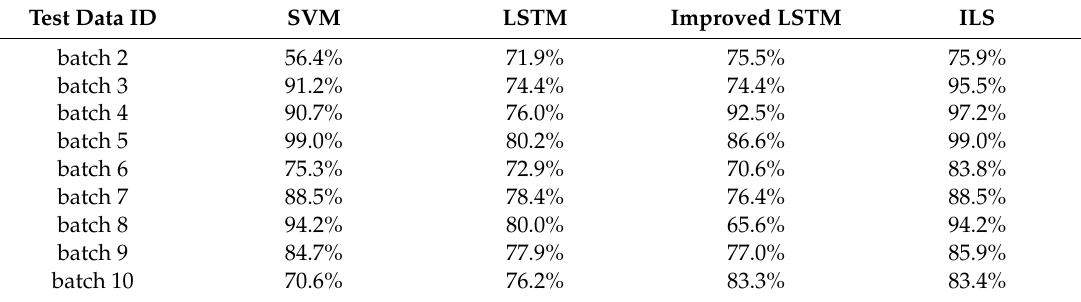
Table 9. Classification Accuracy of ILS Models and other Models.